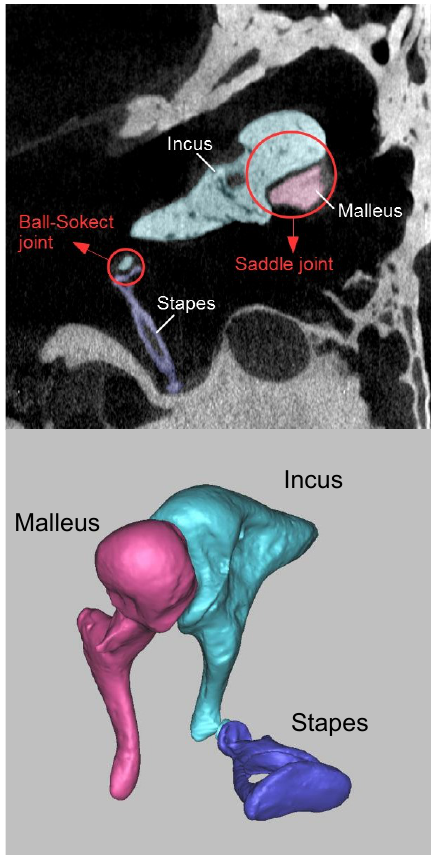
Fig. 3. Segmentation and 3D representation of ossicular